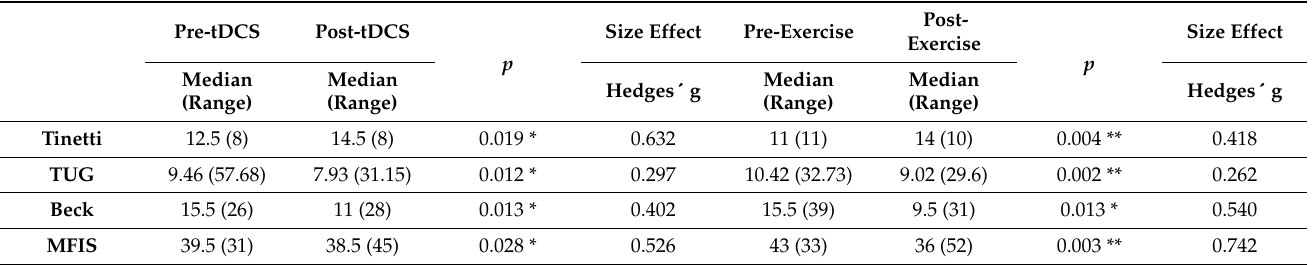
Table 3. Pre–post tDCS and exercise paired samples test: balance, functional mobility, depression, and fatigue.